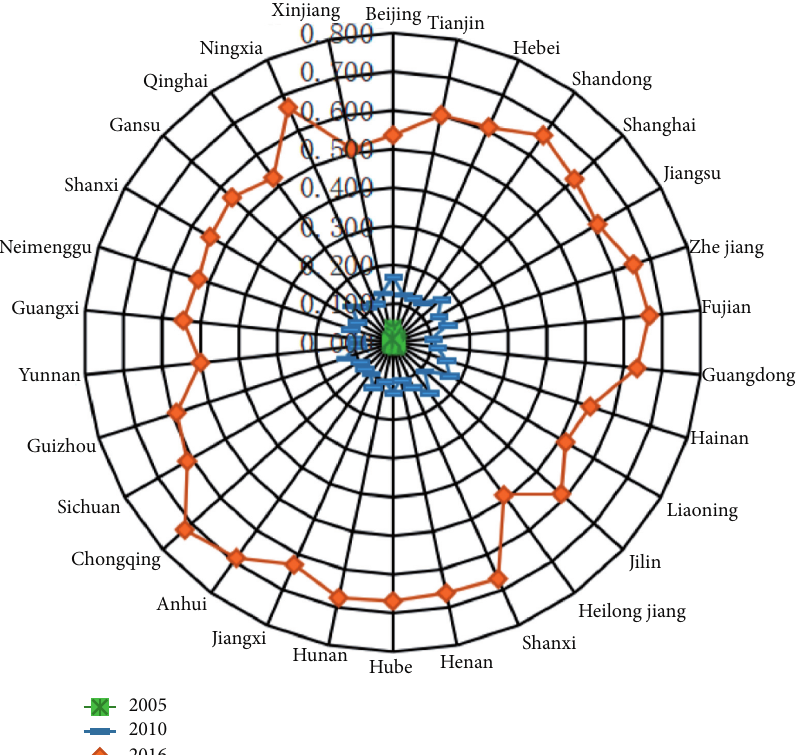
Figure 3: Coupling coordination level of green economy, education development, and technological innovation in 2005, 2010, and